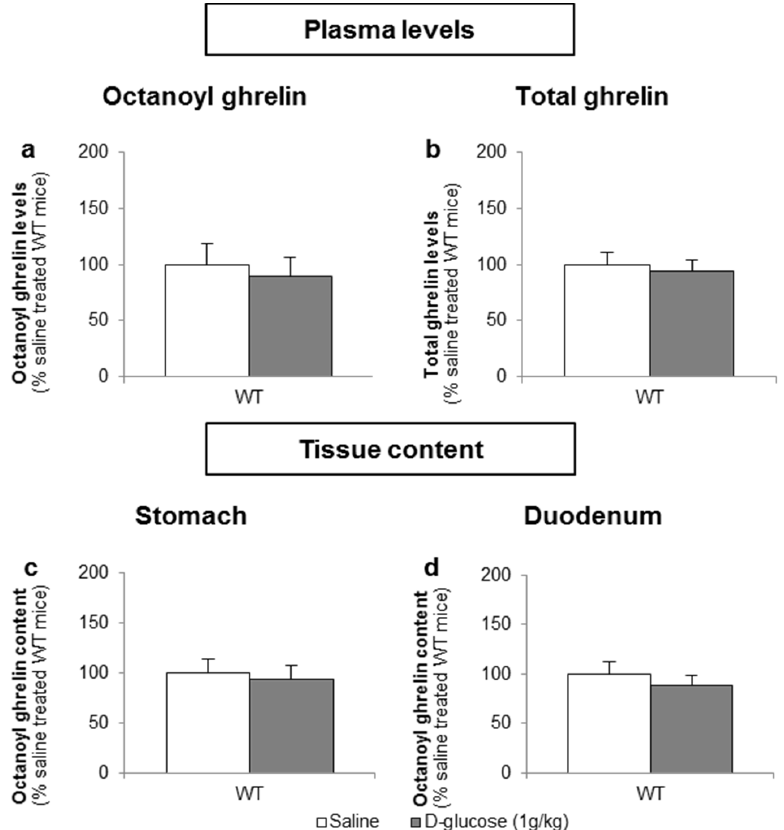
Figure 7. The sensing of D ‐ glucose is polarized and occurs at the luminal side. Mice were intravenously injected with D ‐ glucose (1 g/kg, n = 10) or saline ( n = 11). Ghrelin levels were determined in ( a , b ) plasma, and in protein extracts from the ( c ) stomach and ( d ) duodenum, 40 min after administration. Results (predicted values ± standard error of the predicted values) are expressed relative to the control stimulation (saline treated WT mice).